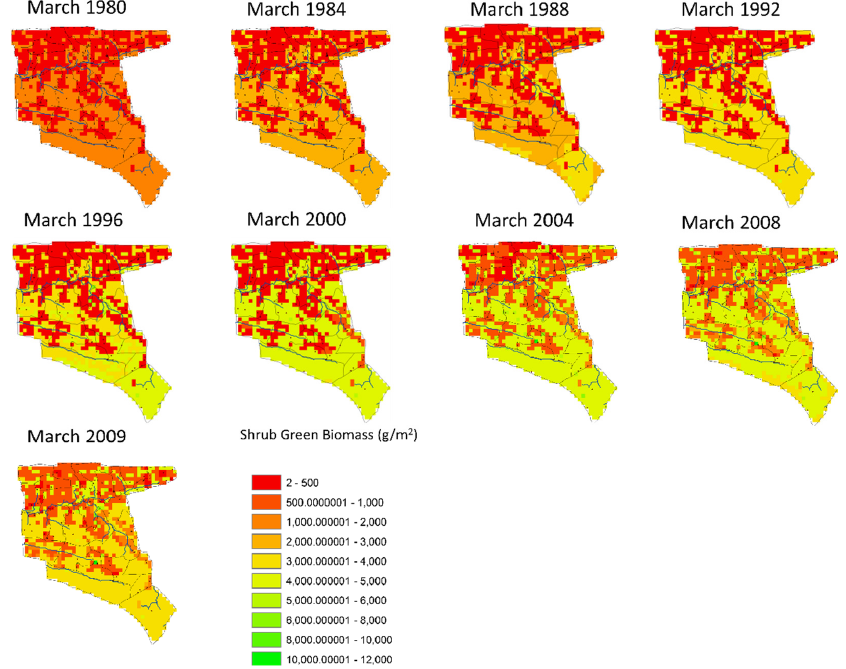
Figure 10. The spatial distribution of shrub green biomass for selected years (March every 4th year of the historic scenario).